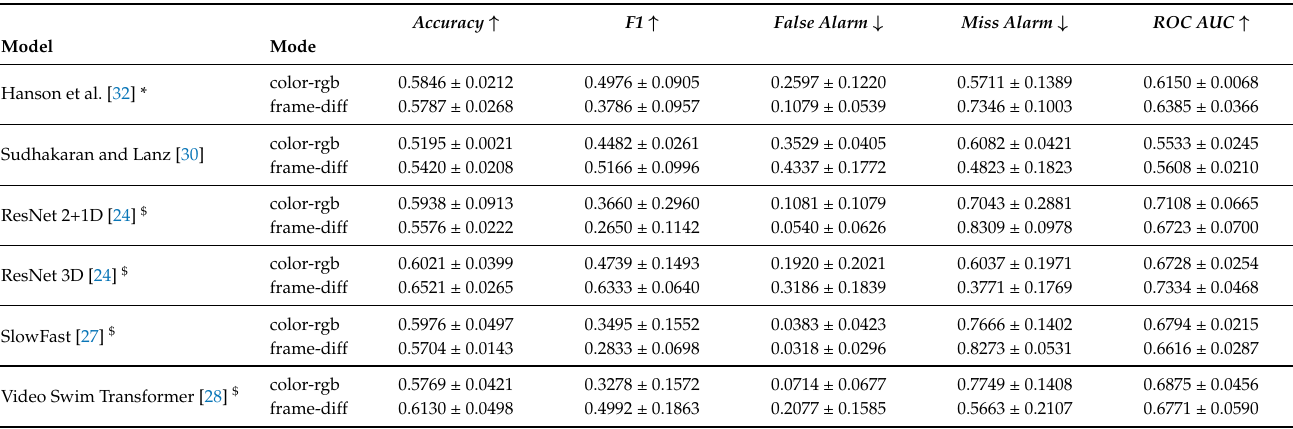
Table 4. Cross-dataset evaluation (pre-training on Real-life Violence Situations [23] dataset, test on our Bus Violence dataset).